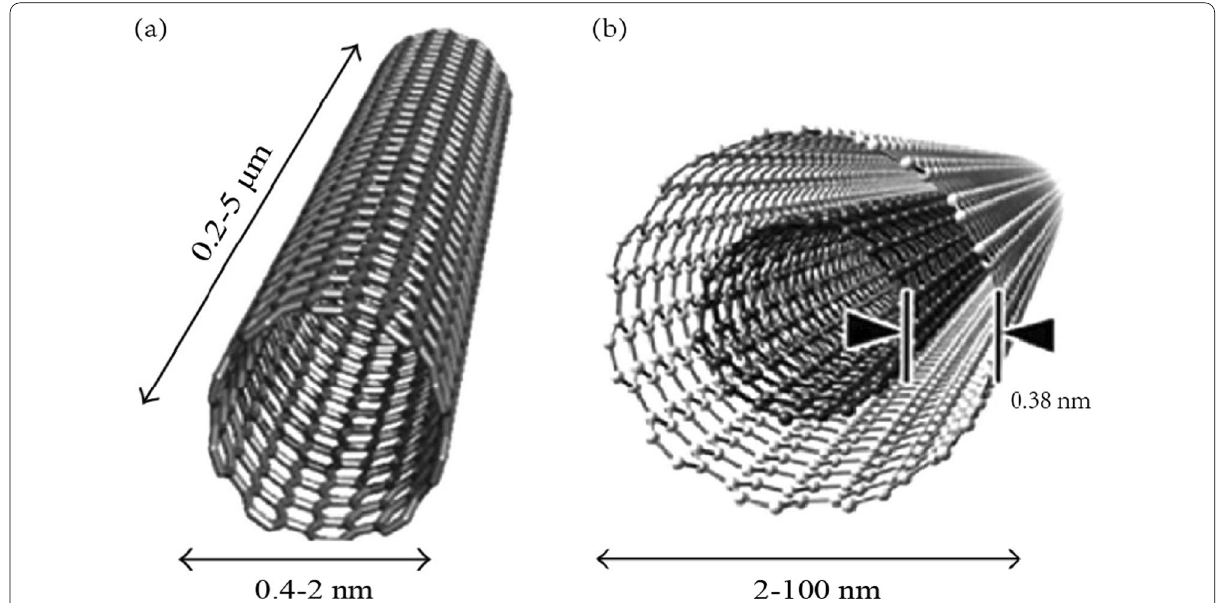
Fig. 1 Conceptual diagrams of single-walled carbon nanotubes (SWCNT) ( a ) and multi-walled carbon nanotubes (MWCNT) ( b ). Referred from [23],